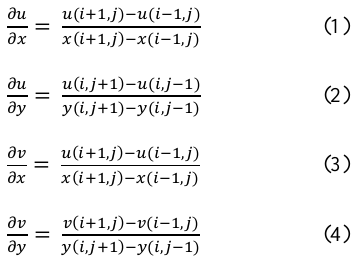
Figure 3. A manifold model to represent six basic types of spatiotemporal transitions (Bothwell, 2011)